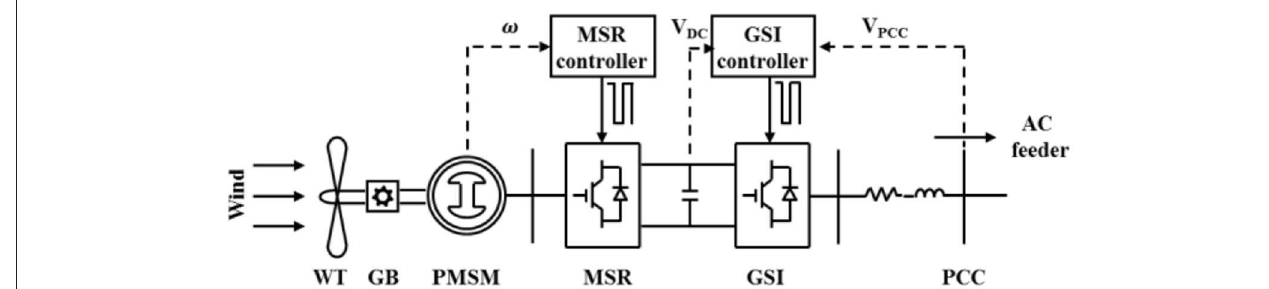
FIGURE 1 | Wind turbine type